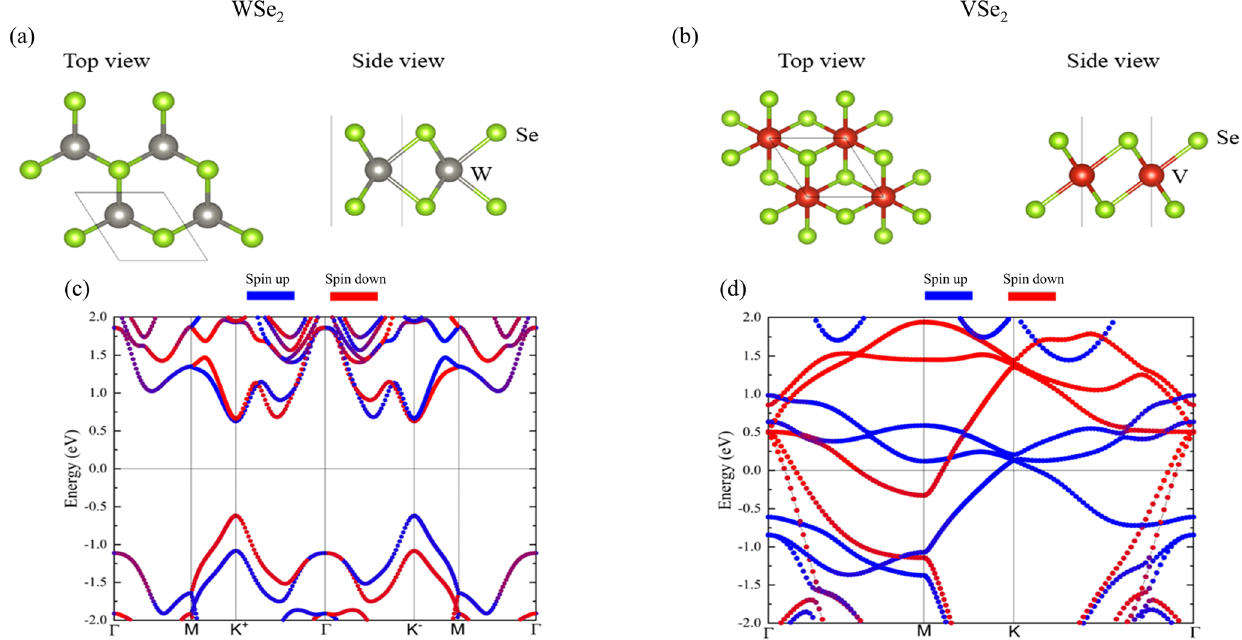
Fig. 1 Structural information and electronic band structure. Top and side views of a WSe 2 monolayer and b 1-T VSe 2 monolayer. Projected band structure including SOC of c WSe 2 monolayer and d 1-T VSe 2 monolayer. Blue and red lines represent the majority spin (spin-up) and minority spin (spin-down) contributions.